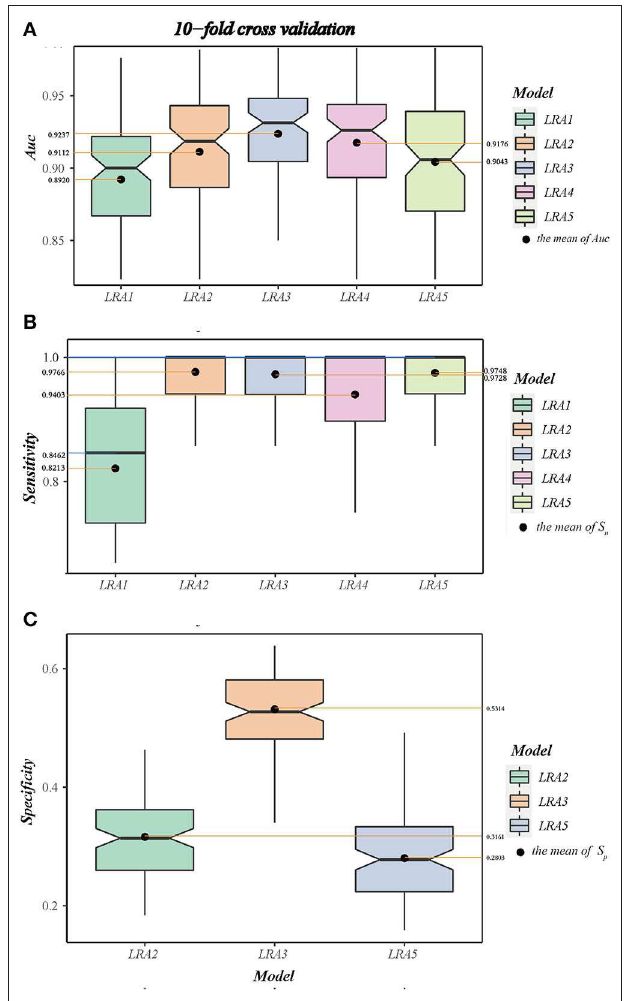
FIGURE 5 | (A) The boxplot A shows the area under curve (AUC) and value interval and relative stability of the LRA1–LRA5 models after 10-fold cross-validation. (B) The boxplot B shows the median and mean sensitivity, value interval, and relative stability of the LRA1–LRA5 models after 10-fold cross-validation. (C) The boxplot C shows the specificity and value interval and relative stability of the LRA2, LRA3, LRA5 models after 10-fold